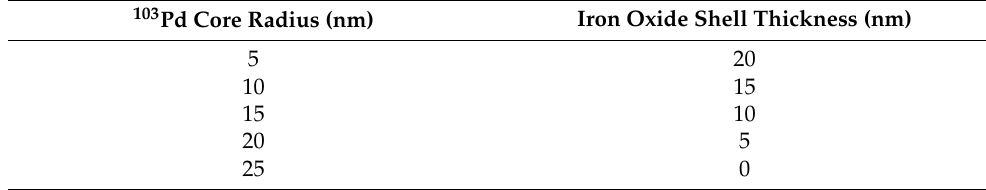
Table 1. Nanoparticle topologies used for the single nanoparticle simulations.